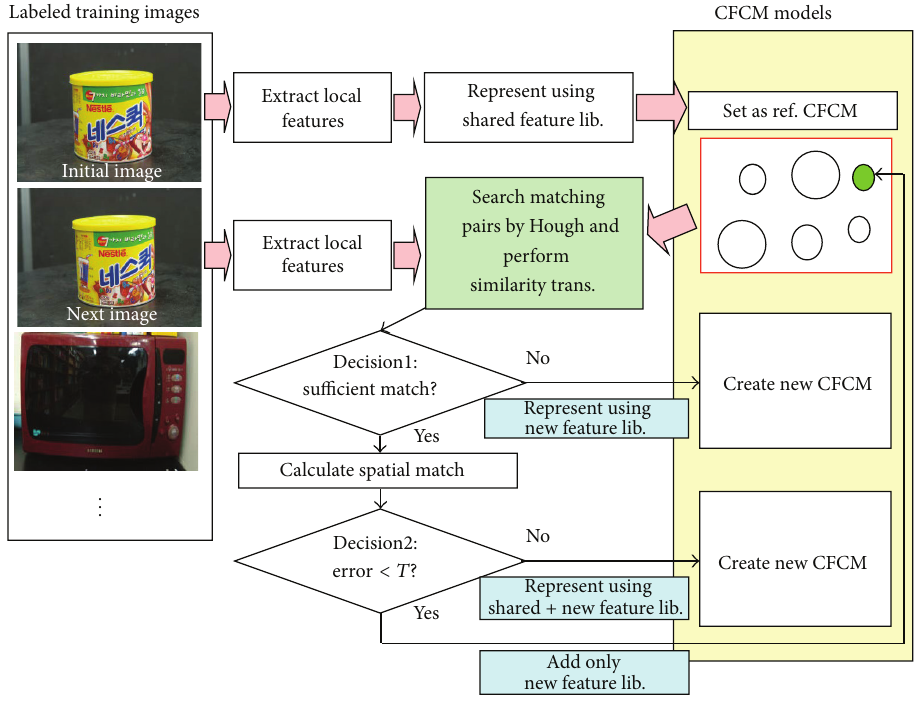
Figure 7: Object learning by sequential view